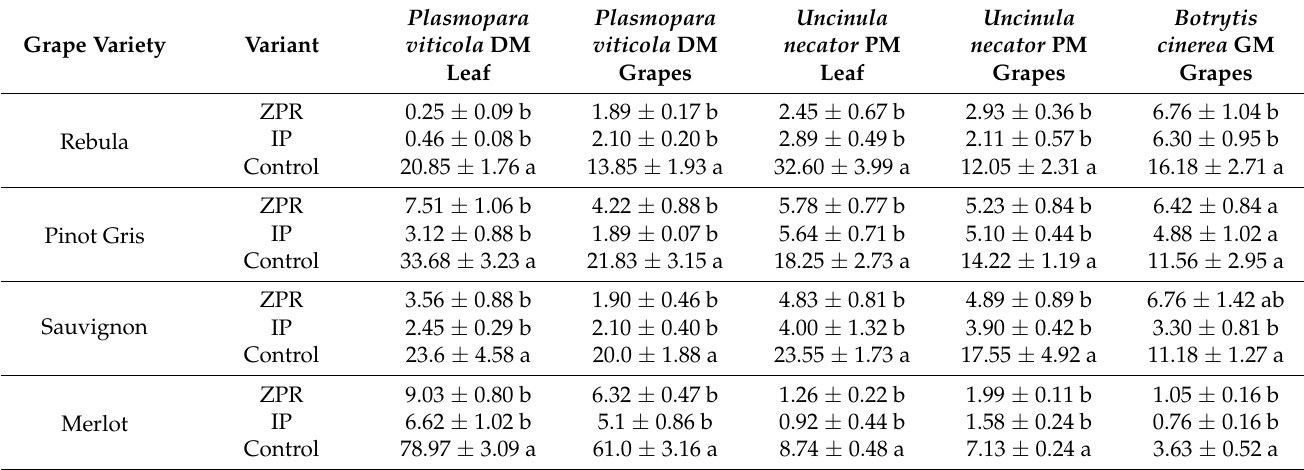
Table 6. Disease infestation rates (% infested area ± SE) at harvest for two grape protection systems (ZPR—0-pesticide residue protection; IP—integrated protection) in four grape